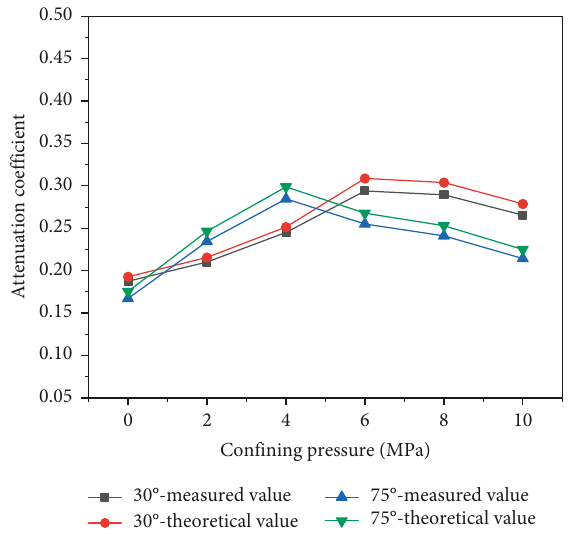
Figure 16: Comparison between theoretical and experimental stress attenuation